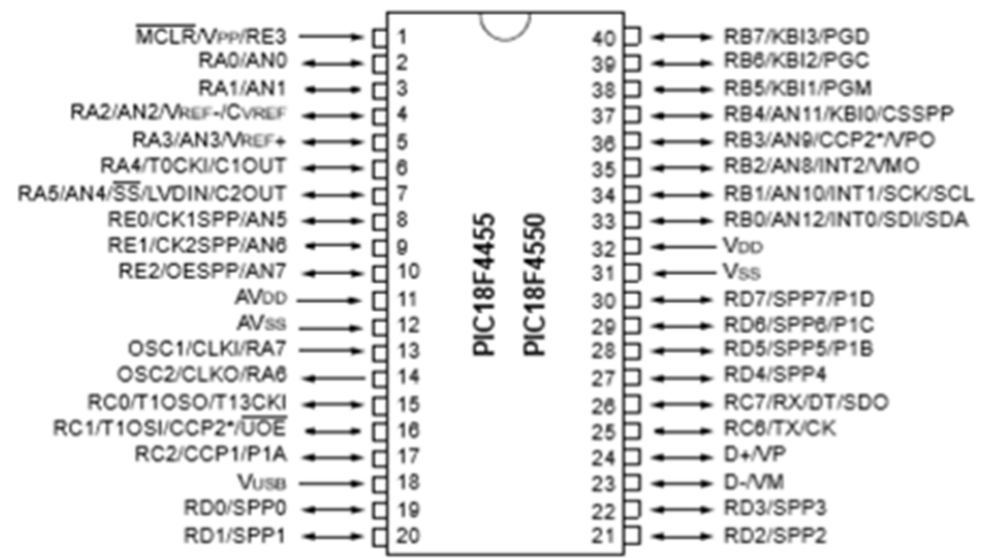
Figure 2. Pin diagram representation of PIC 18F4550.